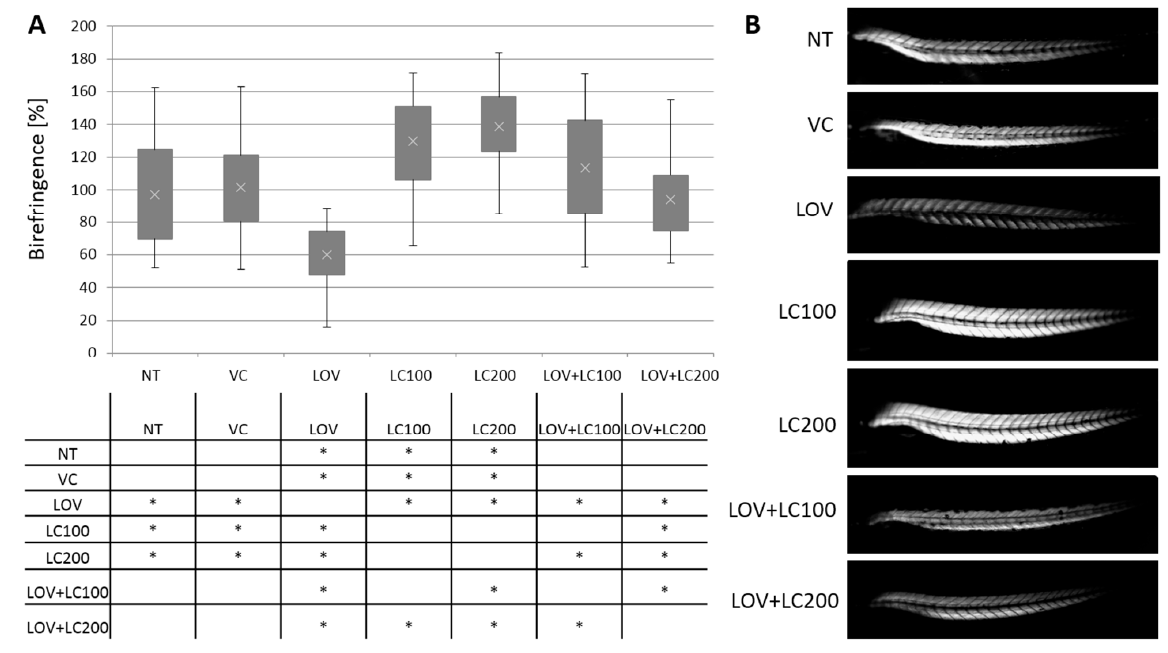
Figure 1. Analysis of skeletal muscle structure of 120 hpf zebrafish larvae exposed to lovastatin (LOV) and L ‐ carnitine (LC) treatment. Control (non ‐ treated, NT; vehicle control, VC; 100 μ M L ‐ carnitine, LC100; 200 μ M L ‐ carnitine, LC200) were compared with experimental groups (0.5 μ M lovastatin, LOV; 0.5 μ M lovastatin and 100 μ M L ‐ carnitine, LOV+LC100; 0.5 μ M lovastatin and 200 μ M L ‐ carnitine LOV+LC200). ( A ) The birefringence of zebrafish larvae trunk skeletal muscles, obtained in polarised light, reflects the qualitative changes in muscle structure (magnification 100x, Leica DM5000 light microscope). ( B ) The quantitative analysis revealed that the differences between groups were statistically significant. The table below indicates the pairwise comparison between investigated groups. Statistically significant differences are indicated with *; * p < 0.05 (ANOVA test followed by the Games–Howell post ‐ hoc test), the experiment was repeated at least three times (with 40 to 86 individuals in each investigated group). Error bars show the standard deviation. The morphology of most of the larvae treated with both lovastatin and L ‐ carnitine showed no significant changes compared to those of all control groups. Of note, we did not observe any significant changes in analysed zebrafish larva morphology in transmitted light microscopy. Neither changes in the zebrafish trunk nor significant malformations in the pericardial region were observed (Supplementary Figure S3). 3.2. Lovastatin Treatment Leads to Sarcomere Malformations in Zebrafish Larva Skeletal Muscle while L ‐ carnitine Has a Protective Effect Previous studies on statins’ impact on zebrafish skeletal muscles involved analysis using light microscopy [7,25,26]. To gain further insight into the nature of the observed muscle damage, we decided to undertake a zebrafish lovastatin ‐ treated ultrastructural analysis of skeletal muscles (Figure 2). Our results of TEM phenotype assessment showed that lovastatin exposure triggers contractile apparatus abnormalities. These involve delamination of filaments within sarcomeres and the disruption of sarcomeric filament organisation